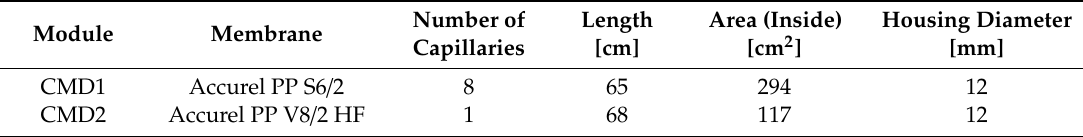
Table 3. Parameters of capillary MD